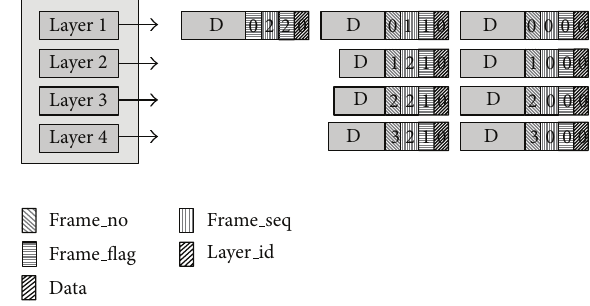
Figure 7: Simulation packet